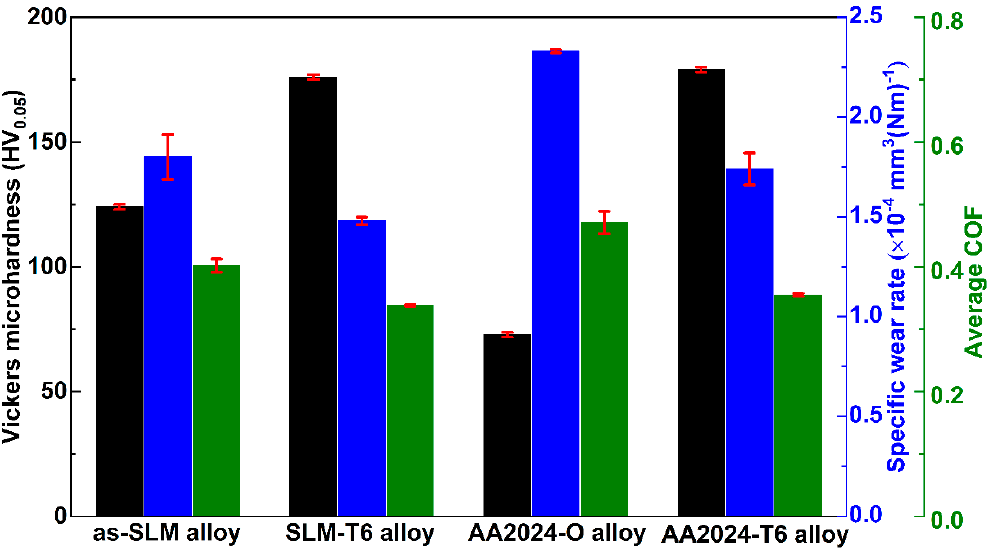
Figure 5. Microhardness, average coefficient of friction (average COF), and specific wear rate of all the samples.